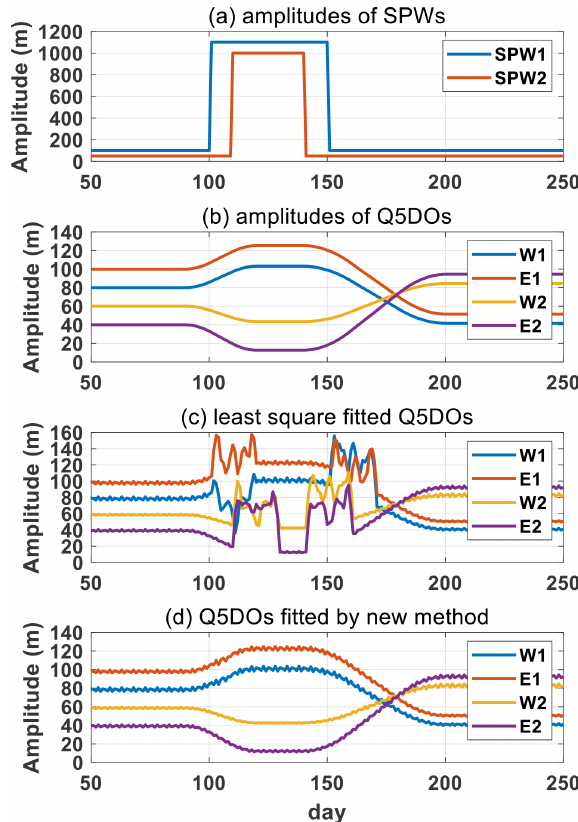
Figure 3. Simulations of the new fitting method based on synthetic data, including (a) SPW1 and SPW2 and (b) westward and eastward Q5DOs with a zonal wave number of 1 and 2. The phase of SPW1 and SPW2 and of the W1, E1, W2, and E2 Q5DOs are set as 0, π/ 6, − π/ 4, π/ 5, − π/ 4, and π/ 3, respectively. (c) Daily amplitudes of the fitted Q5DOs obtained from the original least squares fitting method. (d) Daily amplitudes of the fitted Q5DOs obtained from the new fitting